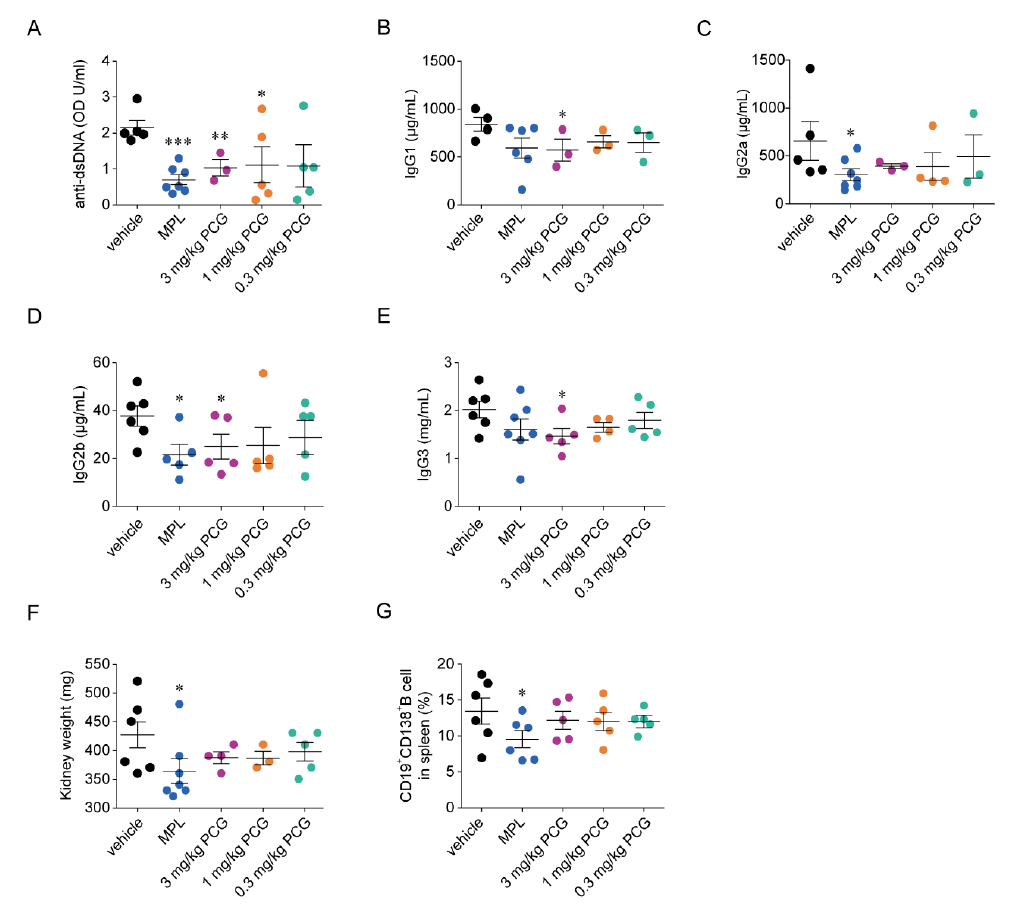
Figure 6. PCG reduces the levels of anti-dsDNA, pathogenic IgG subclasses, and plasma cells. ( A ) Serum concentration of total anti-dsDNA IgG was measured in NZB / W F1 mice at 30 weeks of age (mean ± SEM, n = 3–7 / group). ( B – E ) IgG subclasses were analyzed (mean ± SEM, n = 3–7 / group). ( F ) Summary of kidney weights (mean ± SEM, n = 3–7 / group). ( G ) Mouse splenocytes were isolated, and CD19 + CD138 + plasma cells in spleens were detected (mean ± SEM, n = 5–7 / group). * p < 0.05, ** p < 0.01 and *** p < 0.001 versus vehicle. Two-tailed Student’s t -test ( A – G